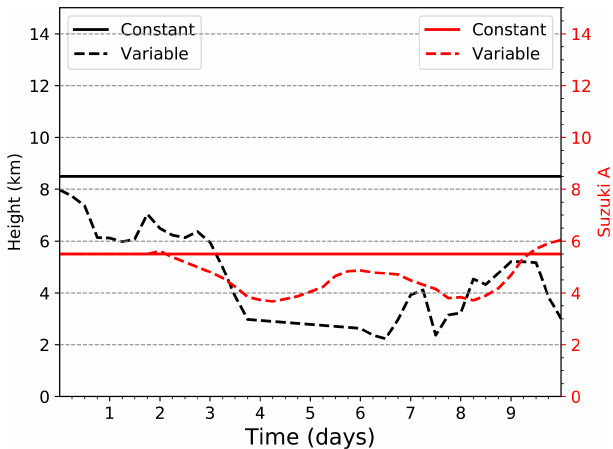
Figure 4. Nature run parameter time series for the constant (solid lines) and variable emission profiles (dashed lines) for h (black lines) and A Suzuki (red